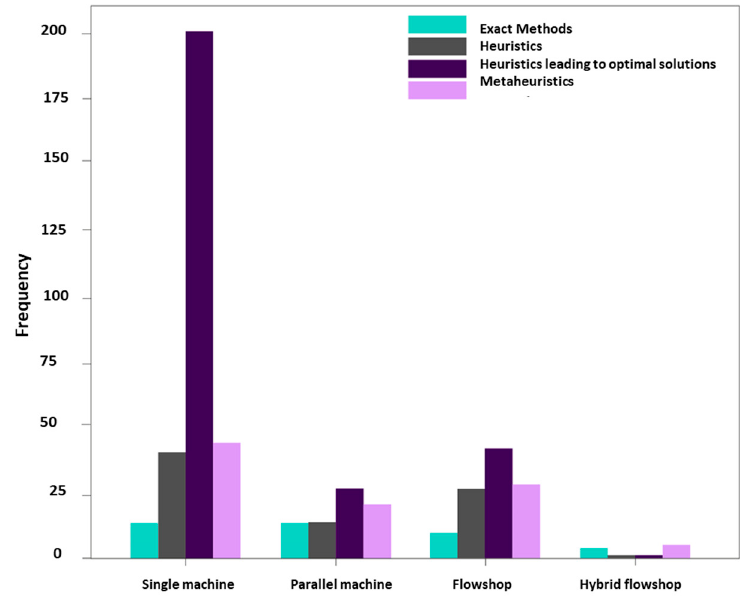
Figure 10. Solution method vs. system configuration.